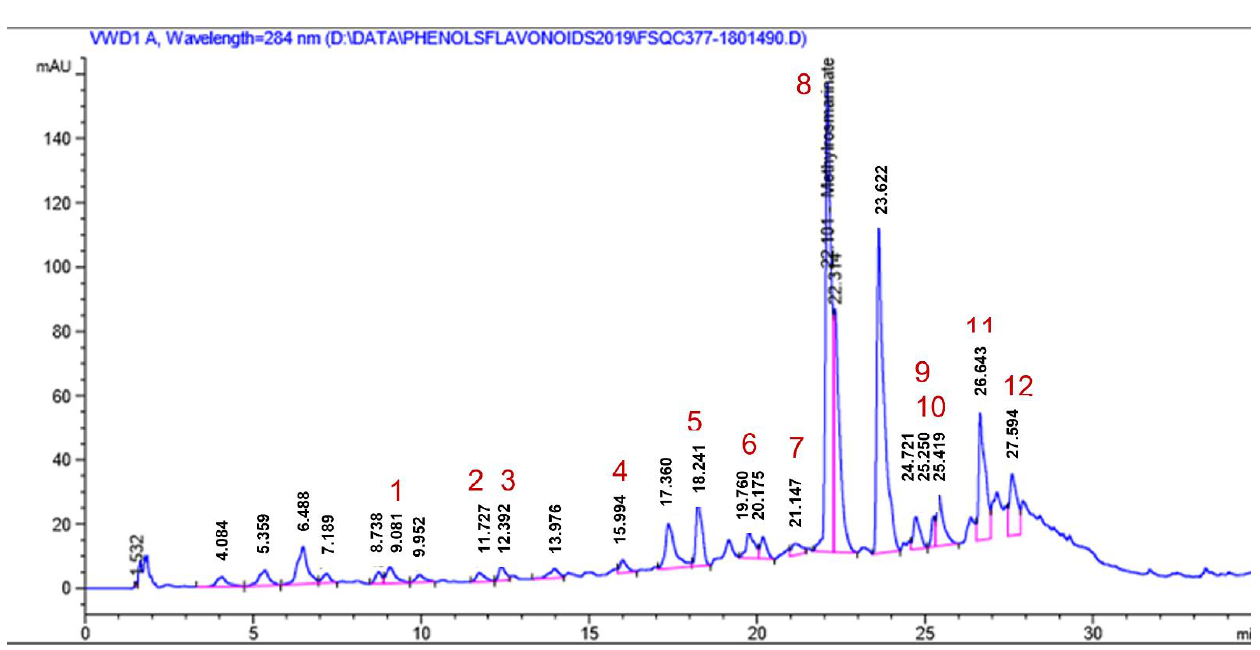
Figure 2. HPLC chromatogram at λ284 nm of the ethanolic extract of Cordia africana Lam. stem bark (2 mg/mL).